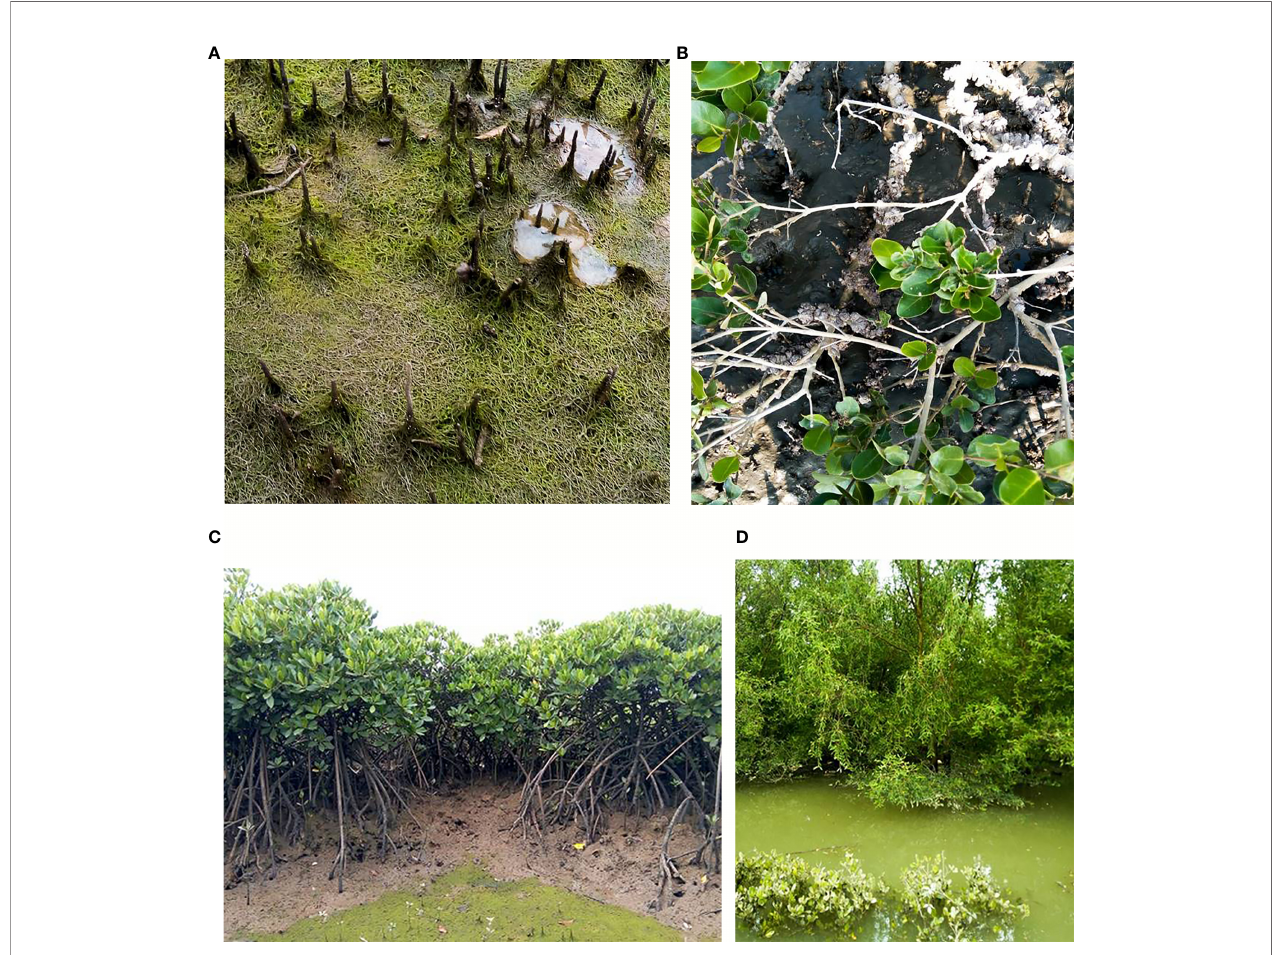
FIGURE 2 | Different sections of the mangrove forest. (A) Mangrove pneumatophores covered with algal bloom. (B) Avecinnia marina bed covered with algal bloom and the plant burdened with high density of barnacles species. (C) Rhizophora forest during low water level with a eutrophic pool of water at high tide. (D) Sonneratia and Avecinnia forest during high water level.